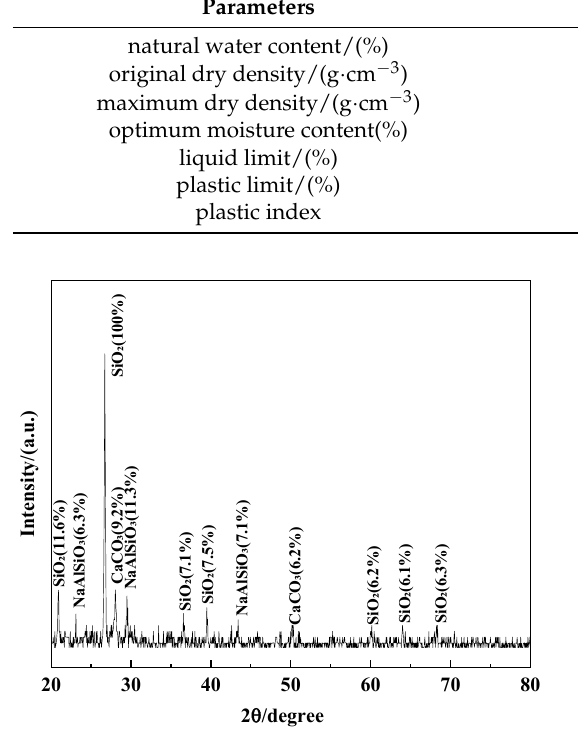
Figure 3. XRD spectrum of soil.